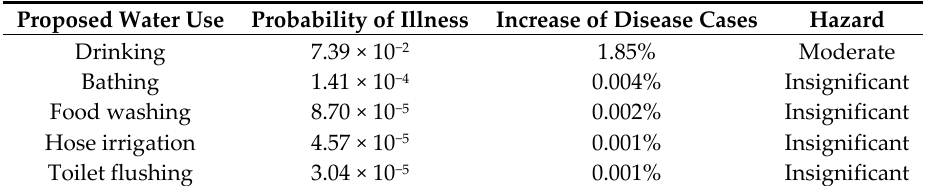
Table 5. Severity of consequences for the proposed RHRW